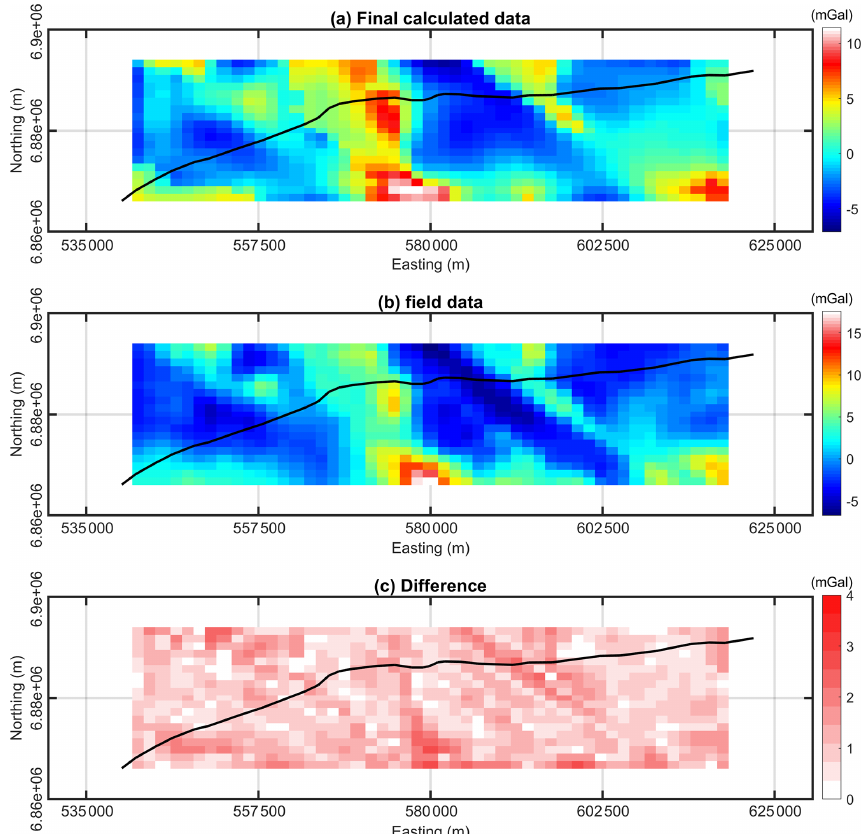
Figure 14. (a) Calculated data from the final constrained inverted model (b) field data and (c) the absolute difference. Solid black lines represent the trace of seismic profile.